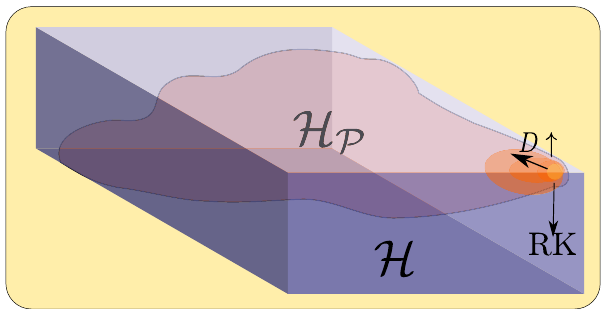
FIG. 1. The Hilbert space H of a quantum many-body system (represented here by a 3D box) is exponentially large, since it is the tensor product of the Hilbert spaces of the constituents. Gauge symmetry allows us to identify a smaller space that we call the physical Hilbert space H . This space is the subspace spanned by P those states that fulfill all the local constraints imposed by the gauge symmetry and is represented by a membrane inside H . H P is smaller than the full H but it is still exponentially large. Low- energy states of local gauge-invariant Hamiltonians, however, are expected to live in a small corner of H , in the same way as low- P energy states of generic local Hamiltonians live in a small corner of H [51 – 54]. For this reason, we design a variational ansatz based on TNs that allows us to explore this small corner of H P (orange oval). By increasing the bond dimension of the elemen- tary tensors in the TN ( D ↑ ), we can explore increasingly large regions of H , and eventually, for D → ∞ , we can cover the P whole H . The projector on H and a family of interesting RK P P states are obtained exactly with a TN with minimal bond ffiffiffi p d dimension that scales as D ≃ , where d is the dimension of the local Hilbert